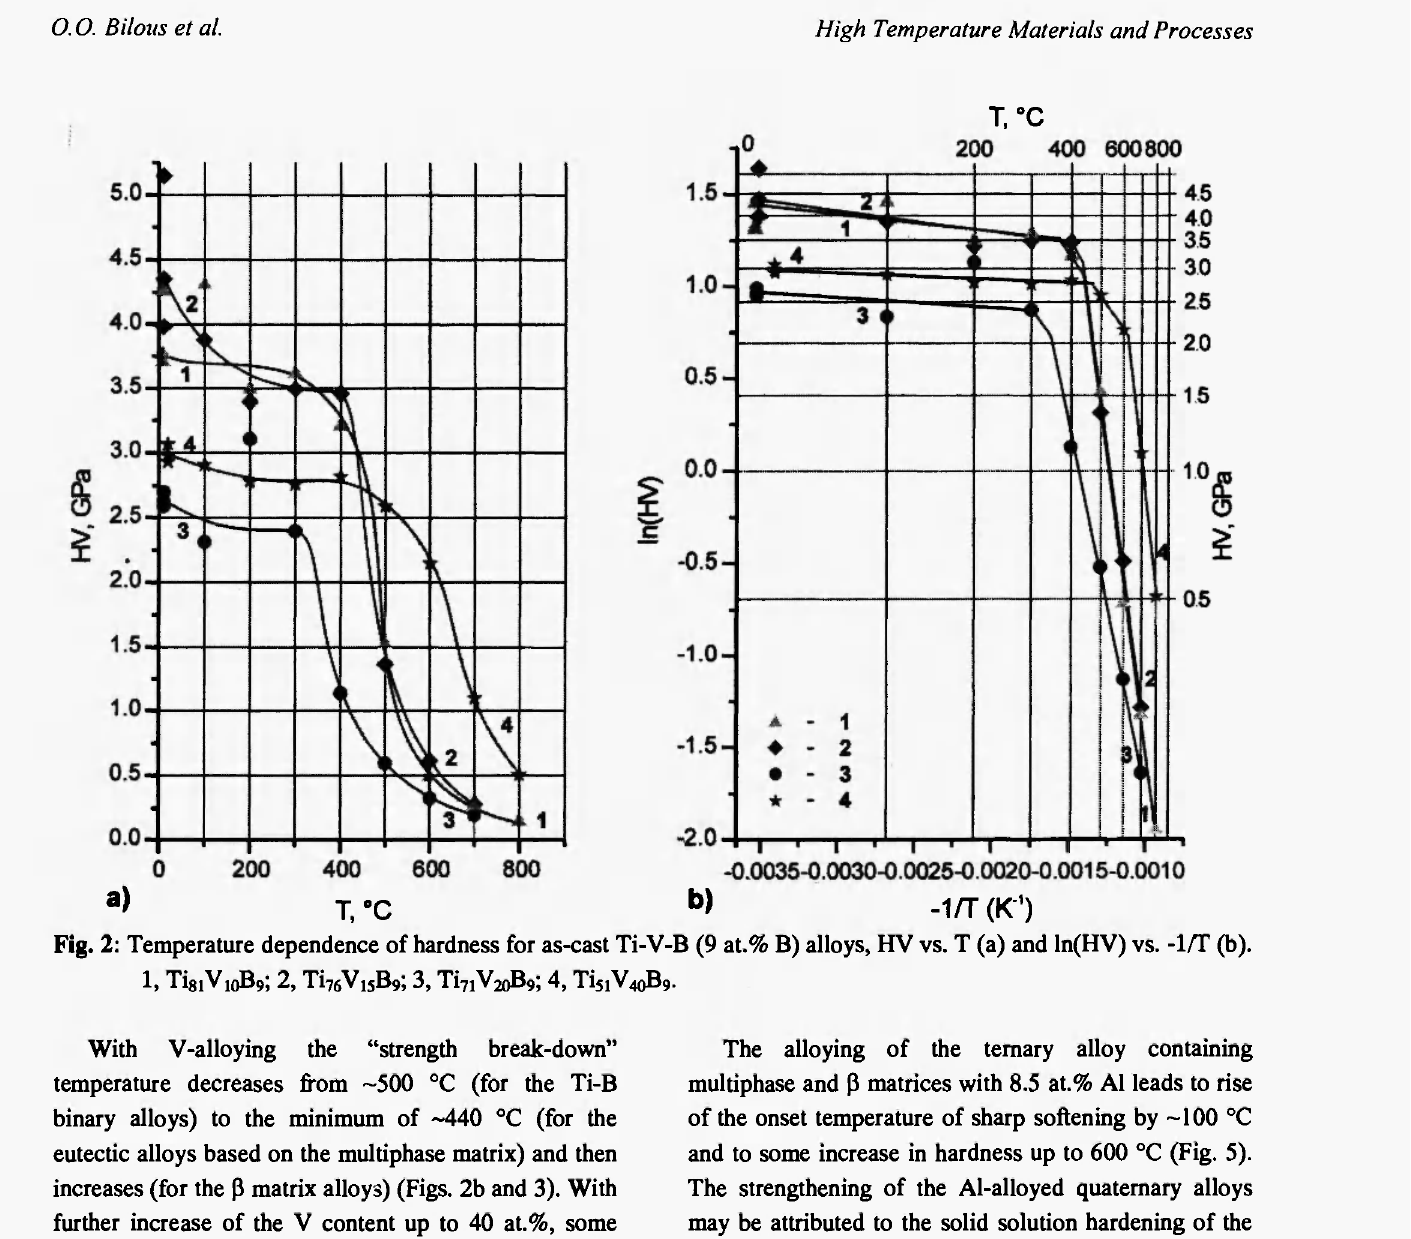
Fig. 2: Temperature dependence of hardness for as-cast Ti-V -B (9 at.% B) alloys, HV vs. Τ (a) and ln(HV) vs. -1/T (b). 1, TigiVioBe; 2, Ti 76 V 15 B 9 ; 3, Ti 71 V2oB 9 ; 4, T i j i V ^ ,. With V-alloying the